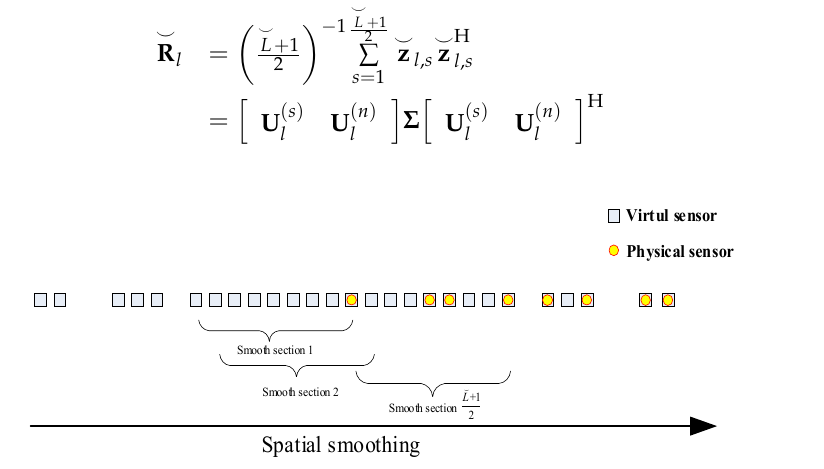
Figure 4. Spatial smoothing of the virtual array.